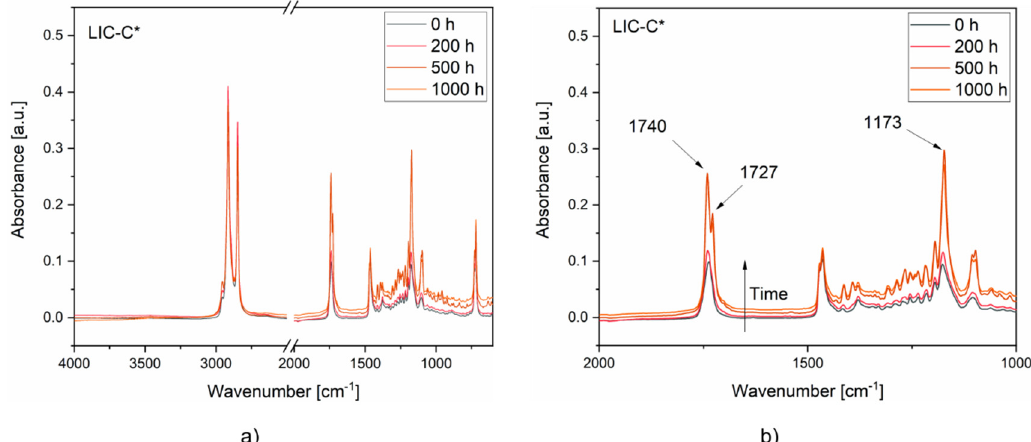
Figure 14. FTIR spectra of the coatings at different exposure times to UV irradiation: ( a ) LIC-C* spectra, ( b ) LIC-C* spectra enlarged in the region of interest.